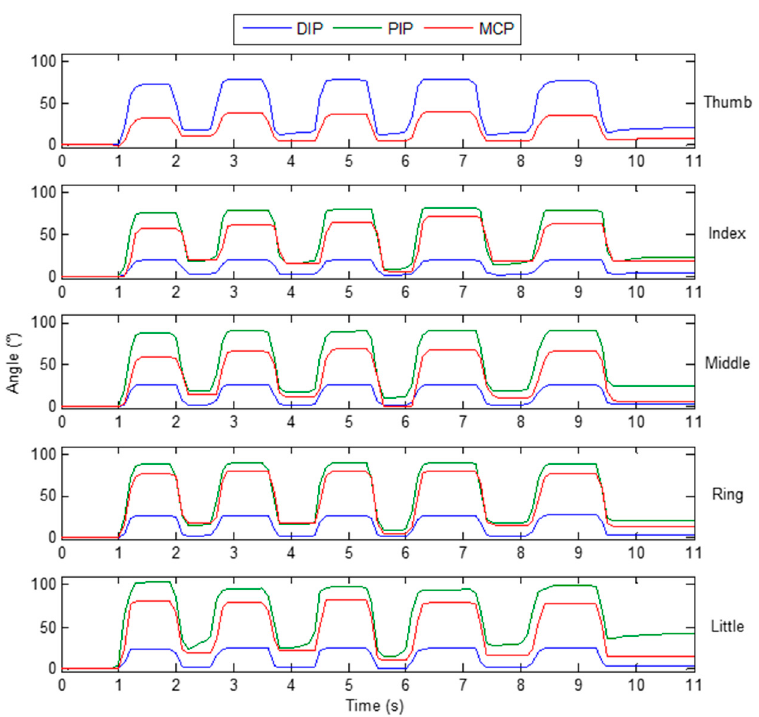
Figure 17. Finger joint angles when a subject makes a continuous grasping motion.